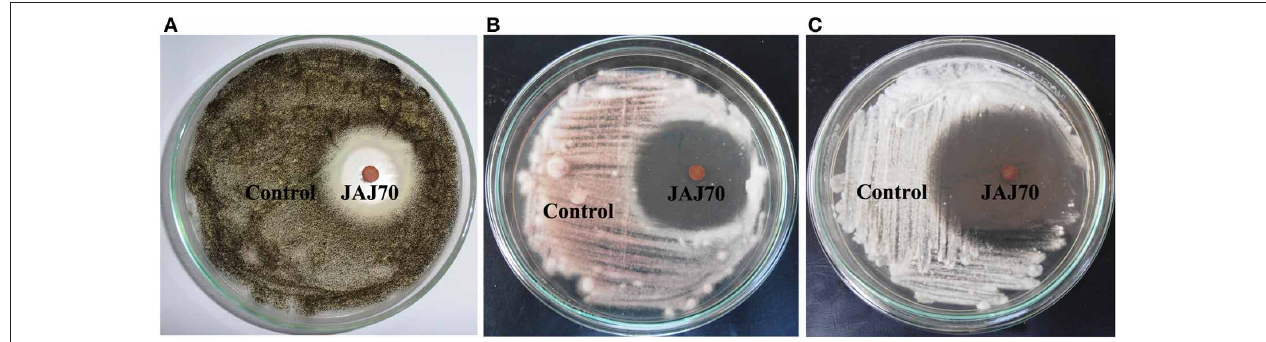
FIGURE 7 | Antifungal activity by disc diffusion method for Actinoalloteichus sp. JAJ70 against three fungal strains (A) Aspergillus niger, (B) Fusarium oxysporum, and (C) Alternaria alternata